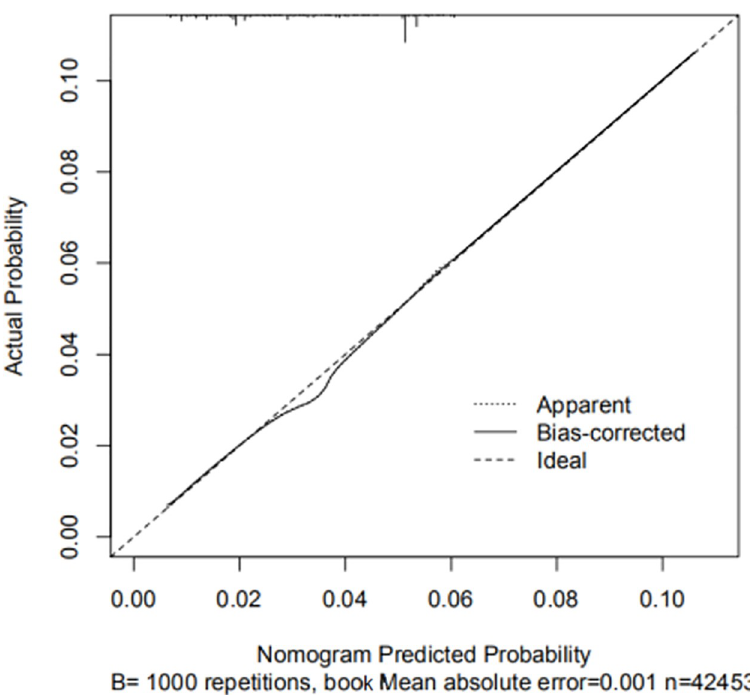
Fig 3. Calibration curve of risk prediction nomogram of metachronous second primary lung cancer.